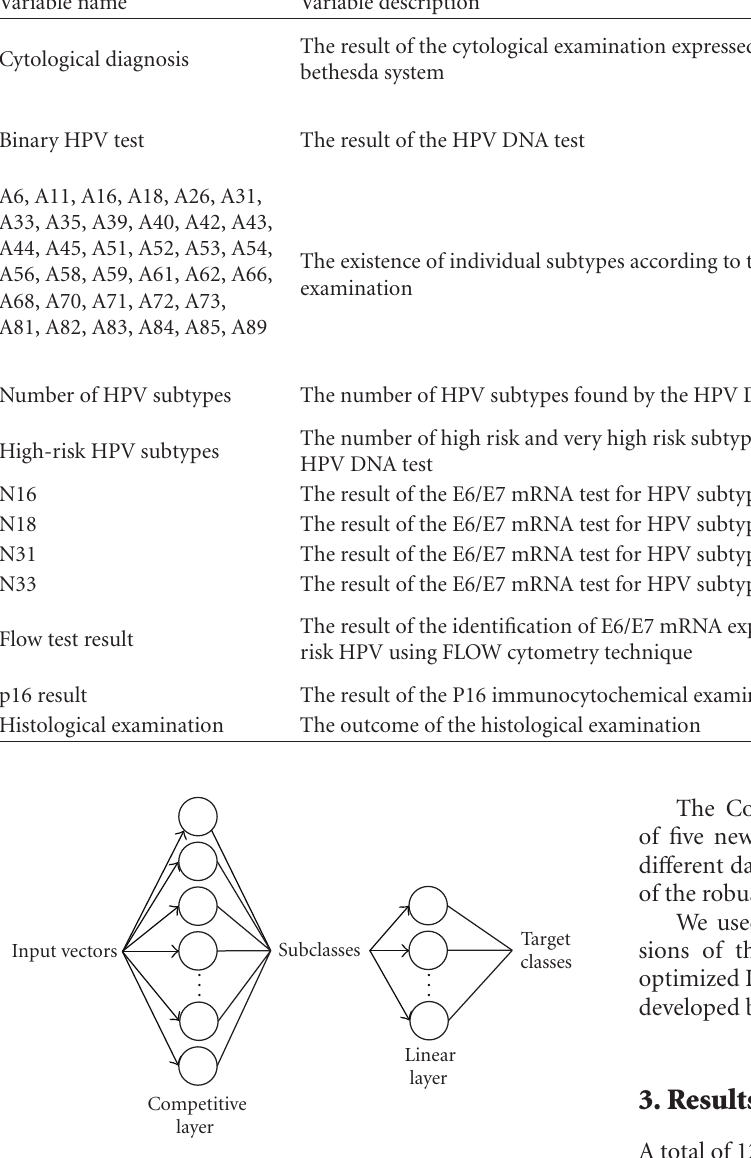
Figure 1: Schematic diagram of LVQ NN